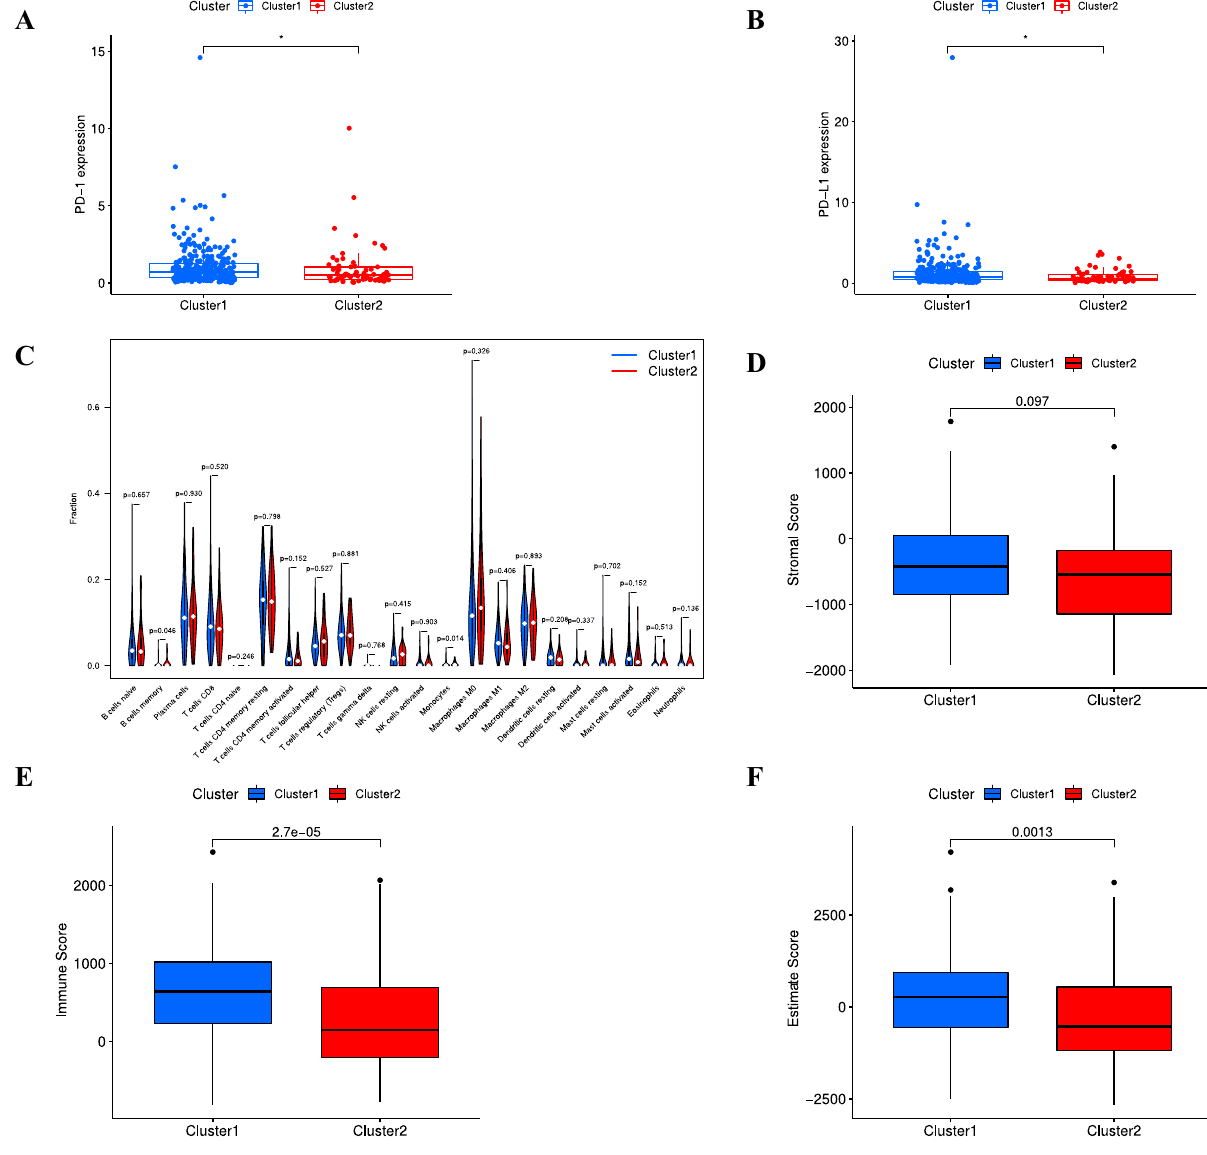
Figure 5. Immune analysis in different cluster subtypes. ( A ) Correlation between cluster subtypes and PD-1, * p < 0.05. ( B ) Correlation between cluster subtypes and PD-L1, * p < 0.05. ( C ) Infiltration of 22 immune cells in different cluster subtypes. ( D – F ) Analysis of stromal scores ( D ), immune scores ( E ), and estimated scores ( F ) in different cluster